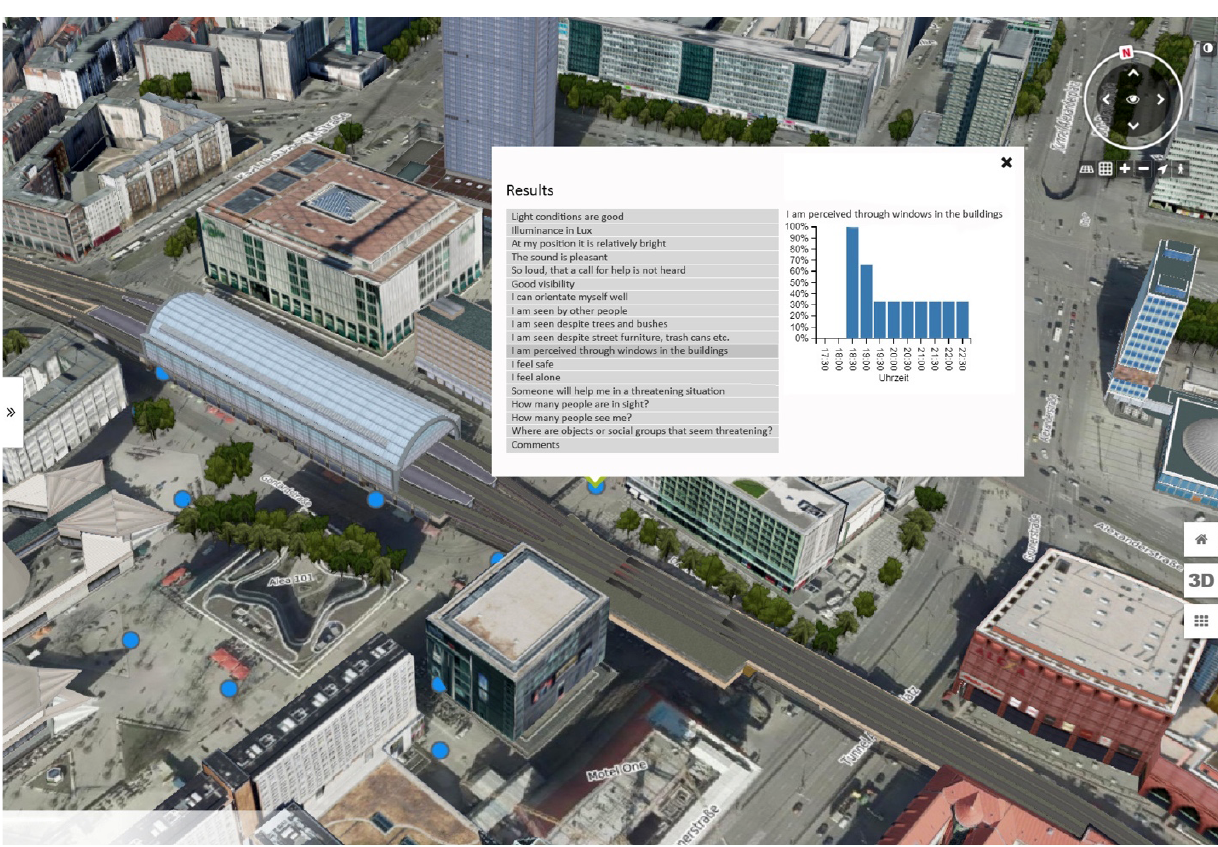
Figure 2. Questionnaire survey on security perceptions at Alexanderplatz. Source: VirtualCitySystems GmbH (Background). perceptions, the use of space and its conflicts of use, measures and best practices. From the expert